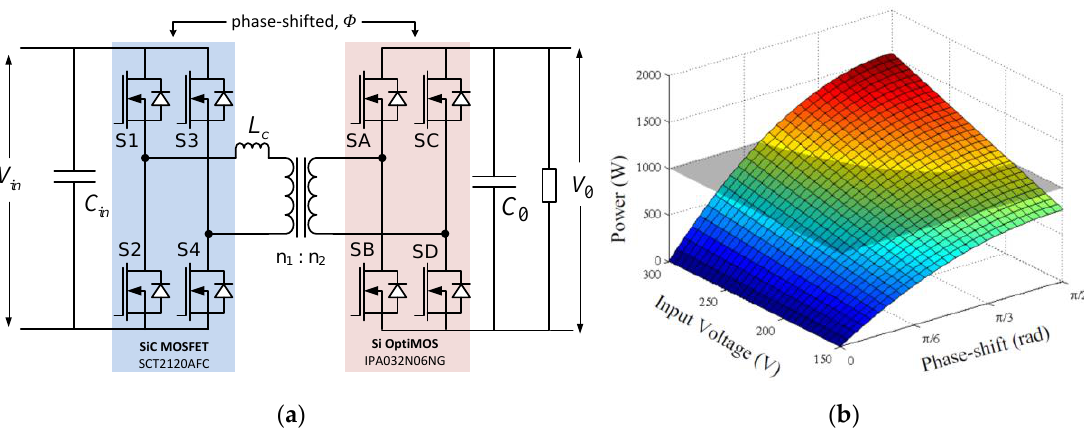
Figure 2. Main features of Dual-Active-Bridge converter: circuit schematic of the converter topology based on SiC MOSFETs or the primary and Si MOSFETs for the secondary side ( a ) and summary of output power delivery as a function of input voltage and phase-shift ( b ).